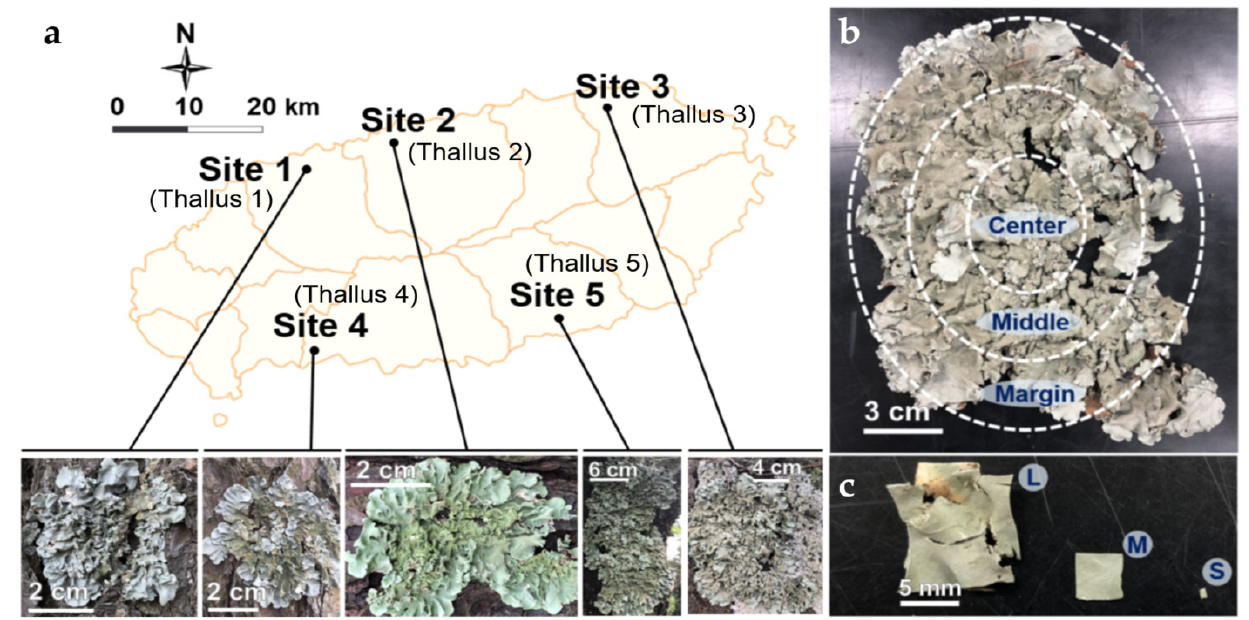
Figure 1. Collection sites and preparation of the thallus samples for ELF isolation. ( a ) Parmotrema tinctorum were collected from five sites in Jeju Island, South Korea; ( b ) Lichen thallus was divided into three parts by its diameter (center, middle and margin); ( c ) The piece of the lichen thallus was cut into three different sizes of inoculum (large: 100 mm 2 ; medium: 25 mm 2 and small: 1 mm 2 ).